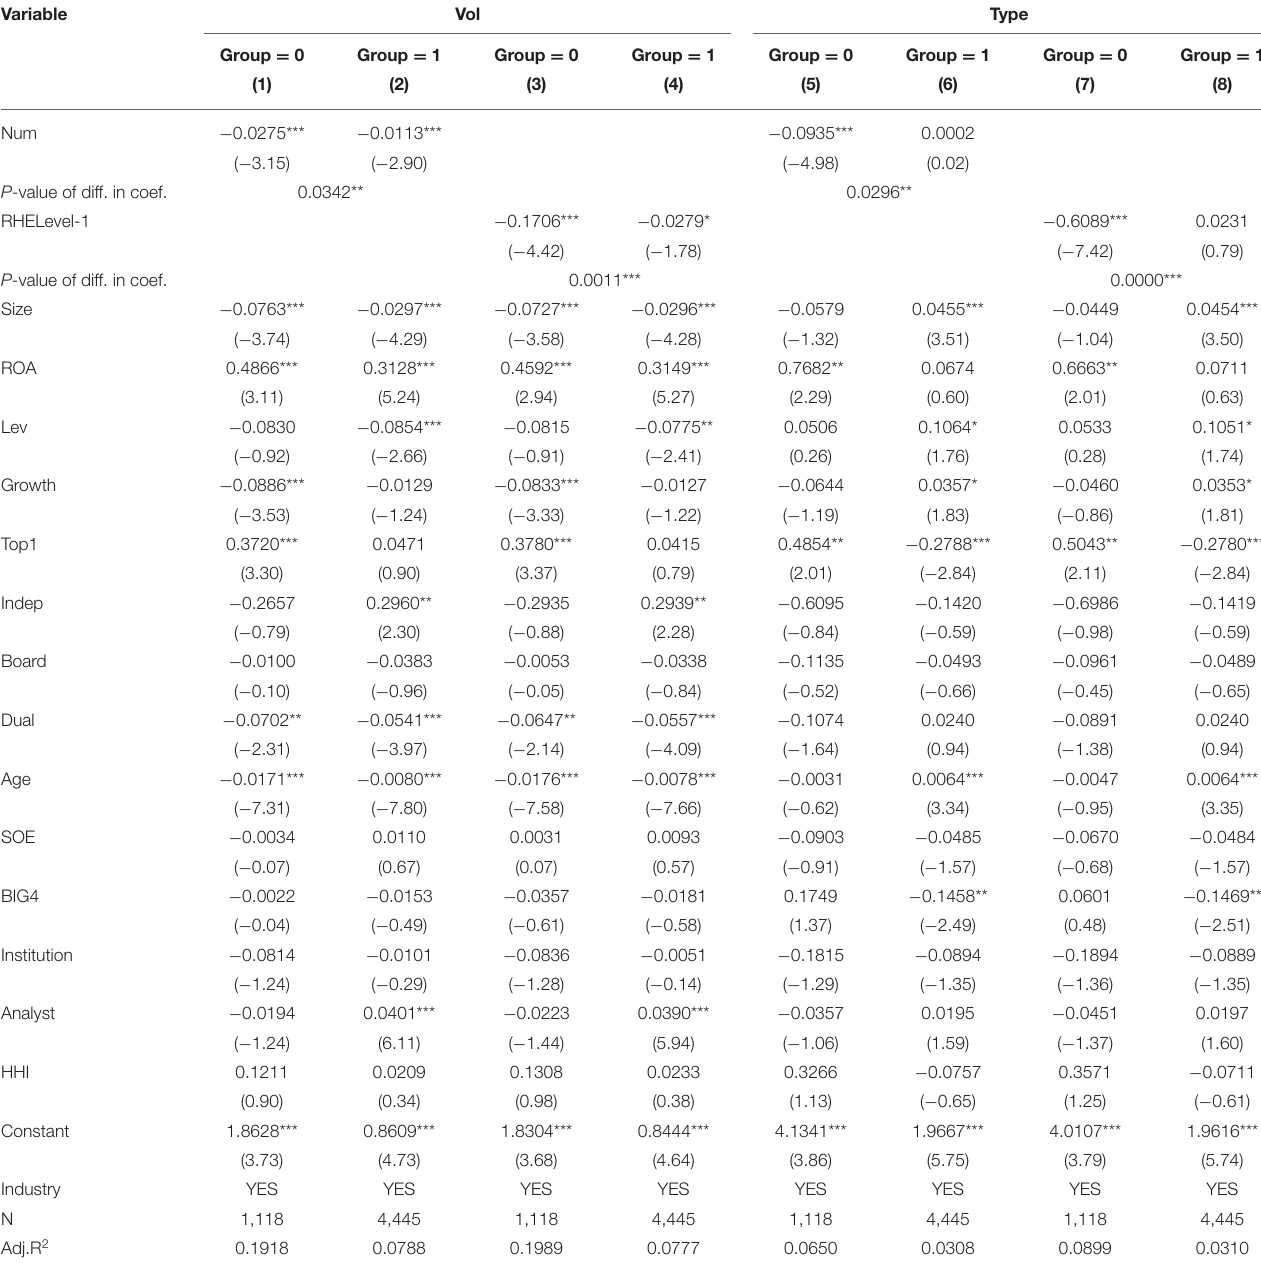
TABLE 18 | Impact of COVID-19 and media tone on the management earnings